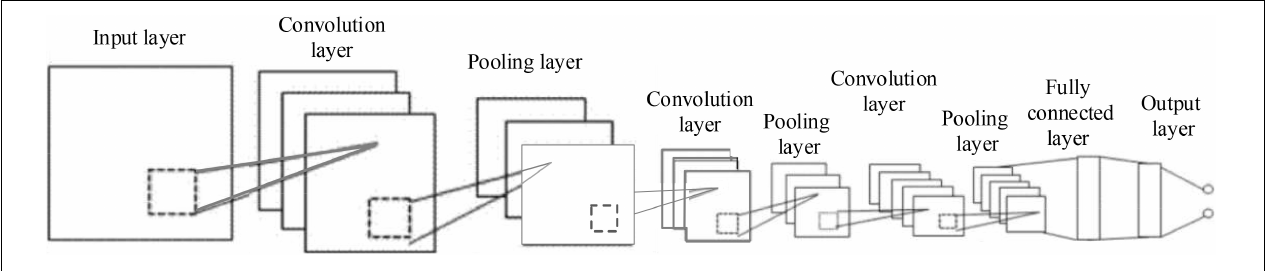
FIGURE 4 | Convolution neural network (CNN) network